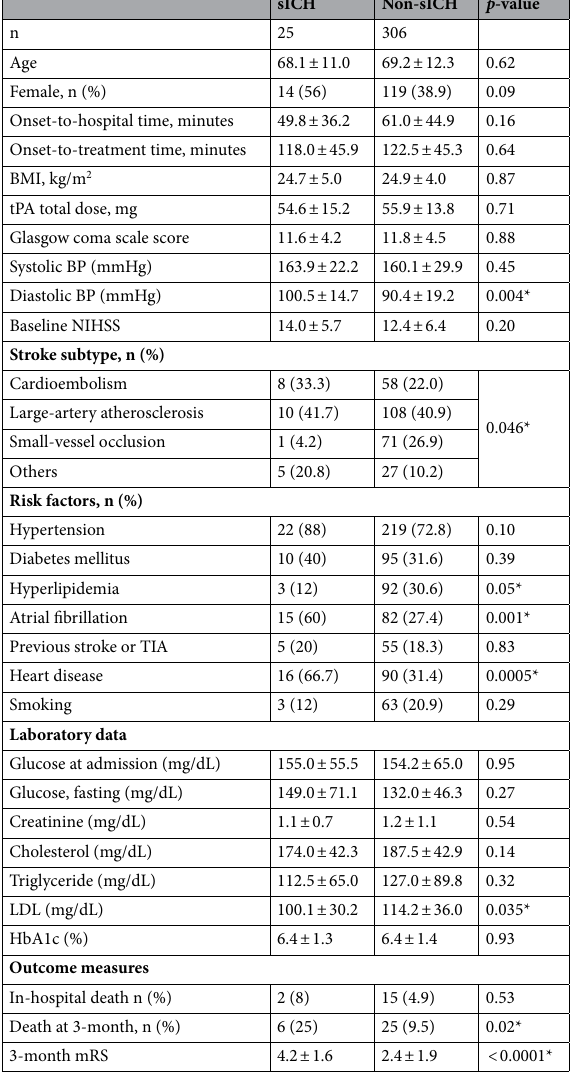
ANN model 2. For model 2, the ANN was trained to predict the 3-month mortality following tPA. The input attributes include age, dose of tPA, baseline NIHSS score, GCS score, history of DM, and history of ischemic heart disease (Table 3). Fasting glucose level was not included in the model because this data was not available before the tPA therapy. After adequate training, the ANN models that contained 13, 15, 15, 15, and 20 neurons in the hidden layer achieved the best predictive performance for the five validation sets (validation 1–5), with a mean training accuracy of 99.3 ± 0.8% and a validation accuracy of 95.2 ± 1.9%. The mean precision of the validation sets was 89.2 ± 6.7%, sensitivity was 94.4 ± 7.9%, and specificity was 95.5 ± 3.0%. The mean AUC was 0.998 ± 0.002 for the training sets and 0.976 ± 0.016 for the validation sets (Figs. 3C,D). Comparison of the predictive performance of ANN models with other prediction scores. To better understand the predictive performance of ANN models and available outcome prediction scores, we cal- culated the Stroke Prognostication using Age and NIH Stroke Scale index (SPAN-100) 6 , Totaled Health Risks in Vascular Events (THRIVE) 7,17 , and Safe Implementation of Treatments in Stroke (SITS) 5 scores with the present clinical data, and used receiver operating characteristic (ROC) curve analysis to compare our ANN models with the scores (Table 4). ANN model 1 and model 2 showed remarkably higher AUC values in ROC analysis than